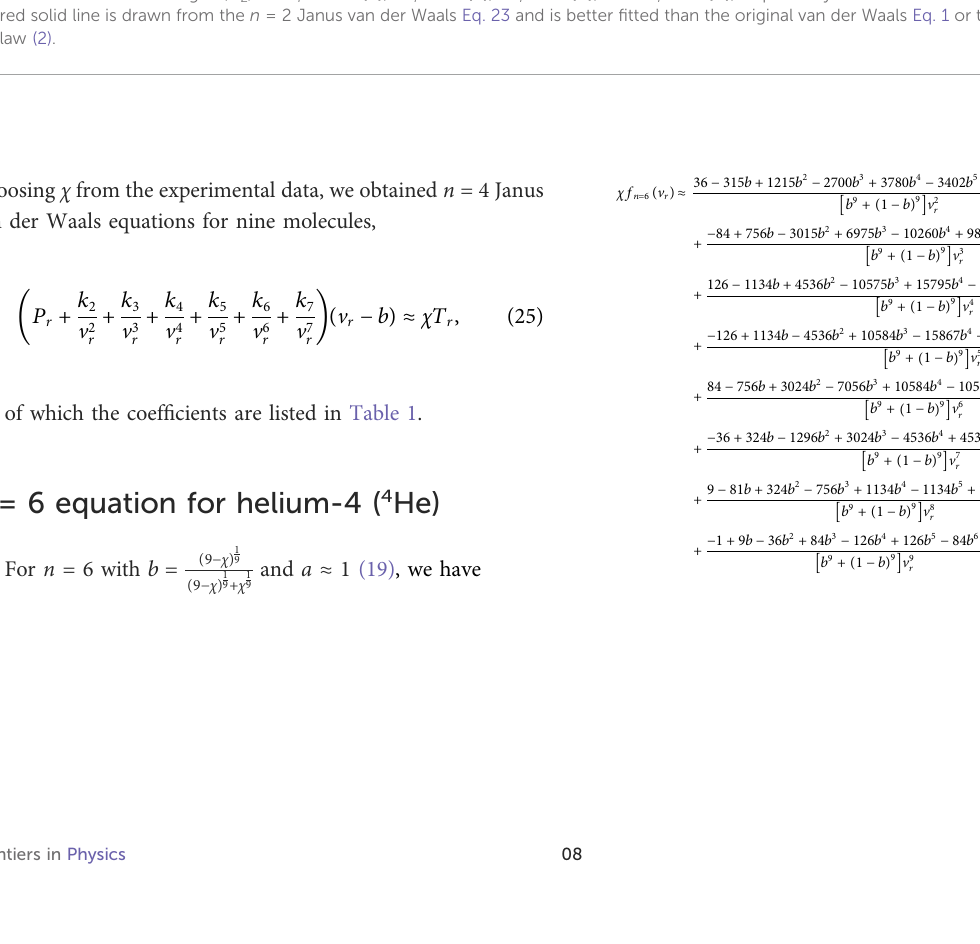
Isochoric curves of nitrogen (N 2 ) at 1/ v r = 0.02 (A) , 1/ v r = 0.5 (B) , 1/ v r = 1.0 (C) , and 1/ v r = 1.5 (D) , respectively. Boxes are from the NIST data. The red solid line is drawn from the n = 2 Janus van der Waals Eq. 23 and is better fi tted than the original van der Waals Eq. 1 or the classical ideal gas law